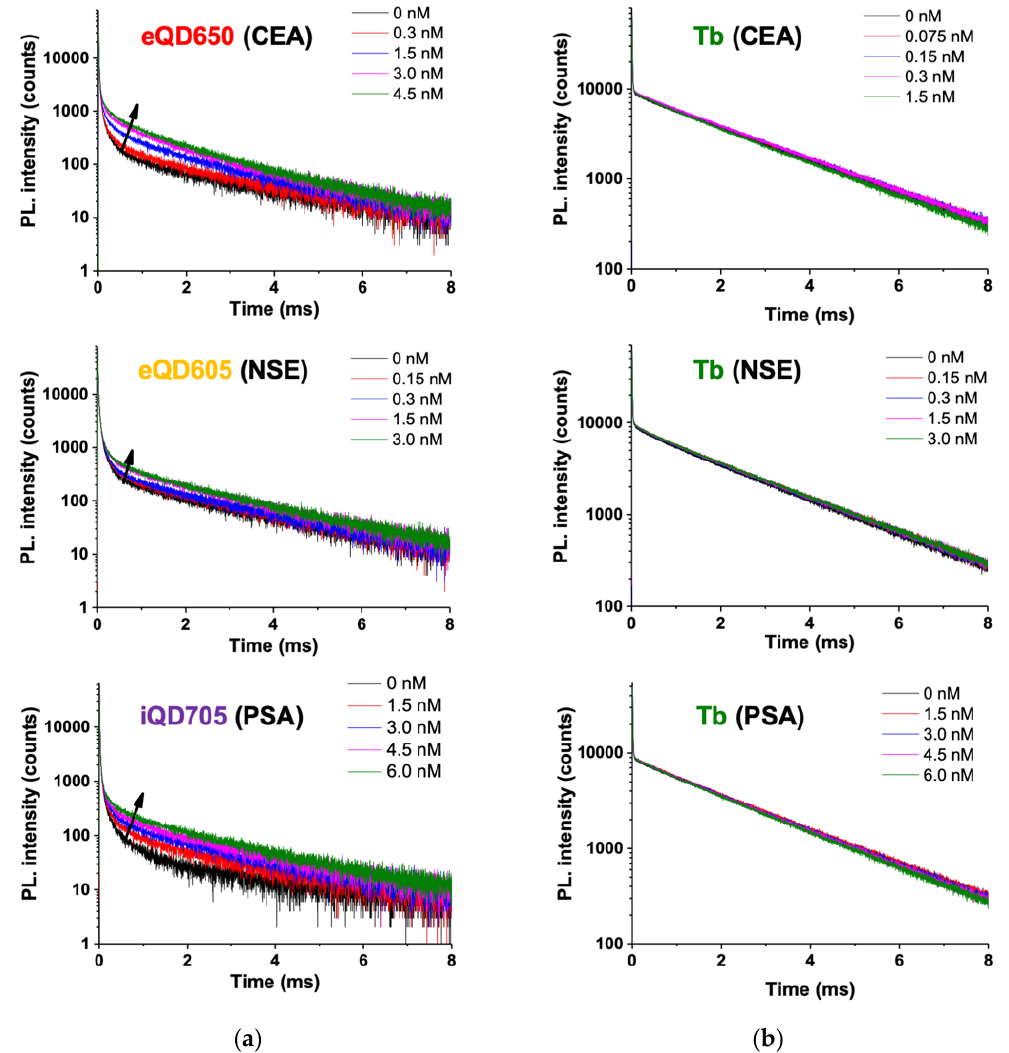
Figure 3. PL decay curves of ( a ) QD acceptors and ( b ) Tb donors with increasing concentration of carcinoembryonic antigen (CEA), neuron ‐ specific enolase (NSE), and prostate ‐ specific antigen (PSA), respectively. Black curves represent the Förster resonance energy transfer (FRET) pairs in the absence of antigens (AG). Very short decay components (in the μ s range) arise from the direct excitation of QDs (visible only in ( a )), and very long decay components (in the ms range) arise from unquenched Tb (visible in both ( a ) and ( b )). With increasing AG concentrations, a new FRET decay component (in the tens to hundreds of μ s range) can be observed with increasing intensity (as indicated by the black arrows in ( a )).